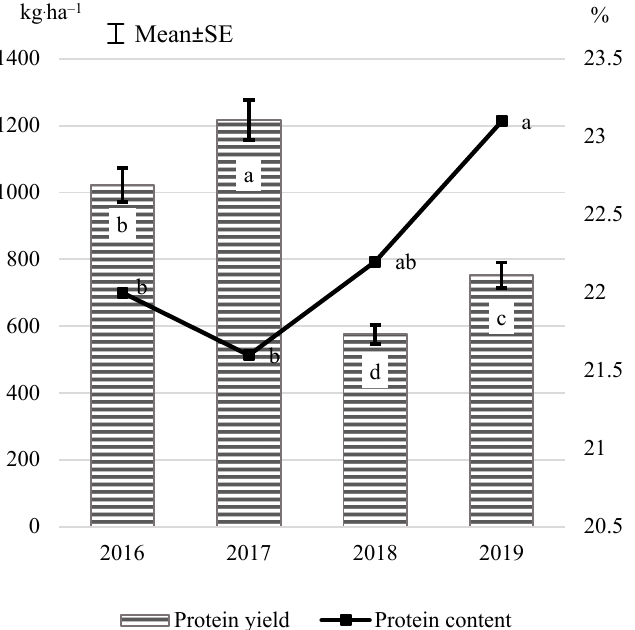
Figure 1. Yield (kg · ha − 1 ) and protein content (%) in pea in the research years. Values of a parameter followed by the same letter did not differ significantly.